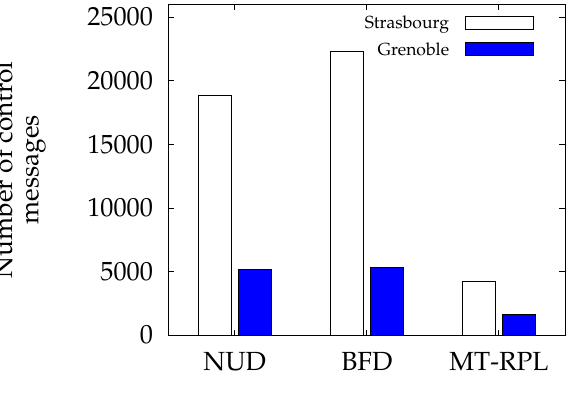
Figure 9. Average number of control messages sent The overall signaling overhead for each